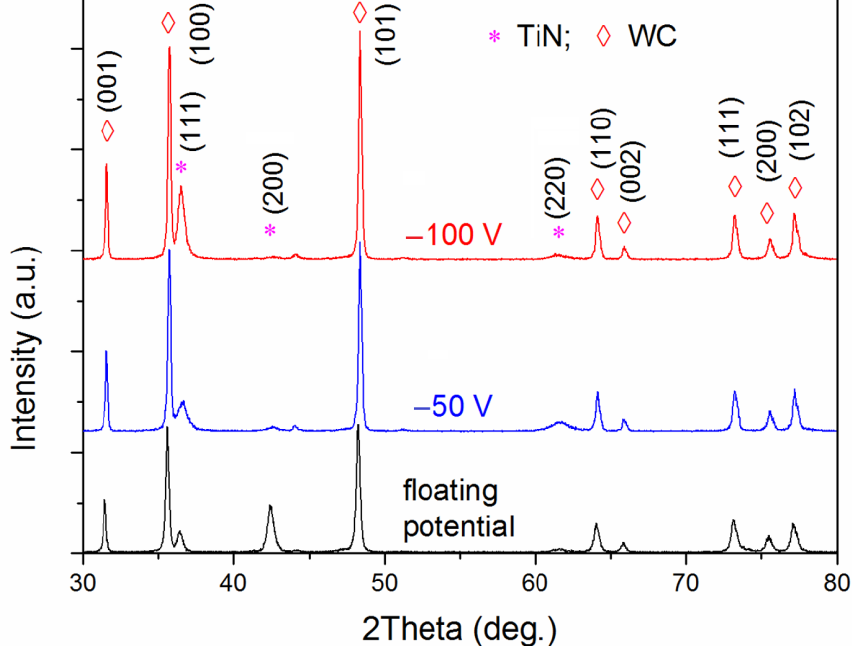
Figure 8. XRD patterns of the TiAlN coatings deposited by the Al magnetron at 30 W of power and different substrate bias voltages.